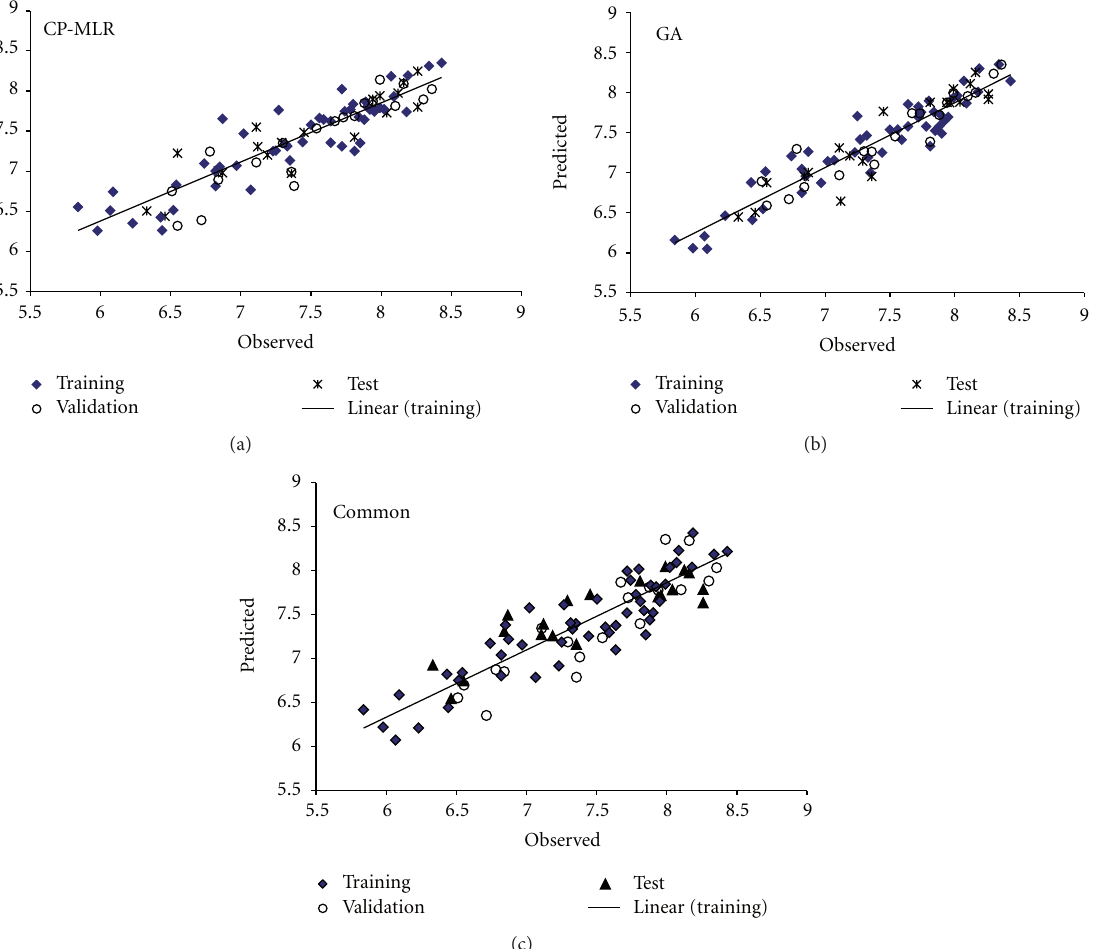
F 4: e plots of observed versus predicted activities of anilinoquinolines’ training, validation, and test sets from BP-ANN models derived using the descriptors of Eq. (1) (CP-MLR), Eq. (6) (GA) (Table 3), and common descriptors of CP-MLR and GA (Table 4). e solid line indicates the best